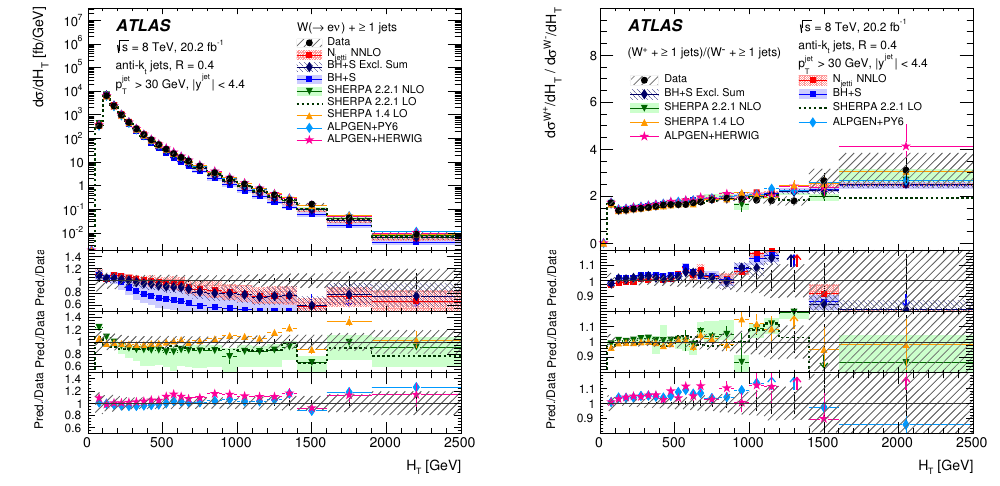
Figure 3 . Di(cid:11)erential cross sections for the production of W bosons (left) and the W + =W (cid:0) ratio (right) as a function of H T for events with N jets (cid:21) 1. The last bin in the left (cid:12)gure includes values beyond the shown range. For the data, the statistical uncertainties are indicated as vertical bars, and the combined statistical and systematic uncertainties are shown by the hatched bands. The uppermost panel in each plot shows the di(cid:11)erential cross sections, while the lower panels show the ratios of the predictions to the data. The theoretical uncertainties on the predictions are described in the text. The arrows on the lower panels indicate points that are outside the displayed range.